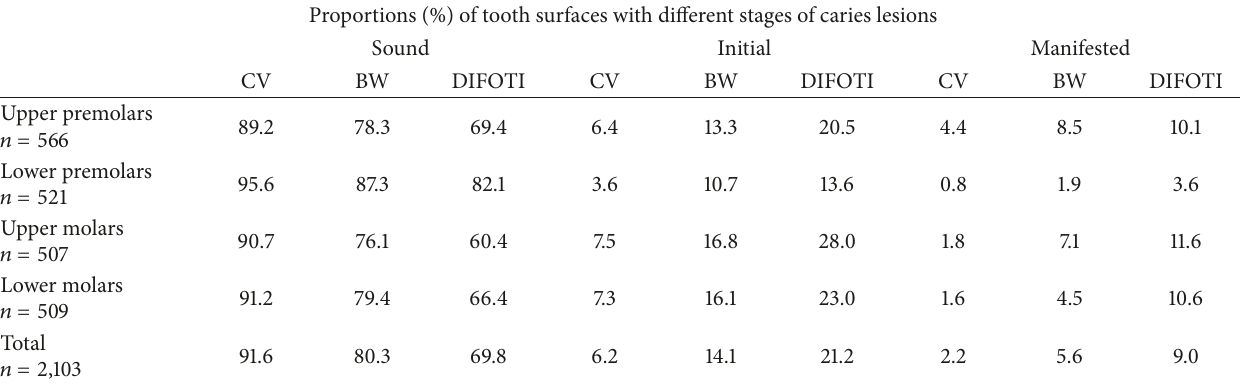
Table1:Distributionofsurfaceswithdifferentstagesofdentalcaries.Findingsoftheclinicalvisualmethod(CV),bitewing(BW)radiographs, and fiber-optic transillumination (DIFOTI) are presented separately for upper and lower premolars and molars. The total number of analyzed tooth surfaces was 𝑛 = 2 , 103